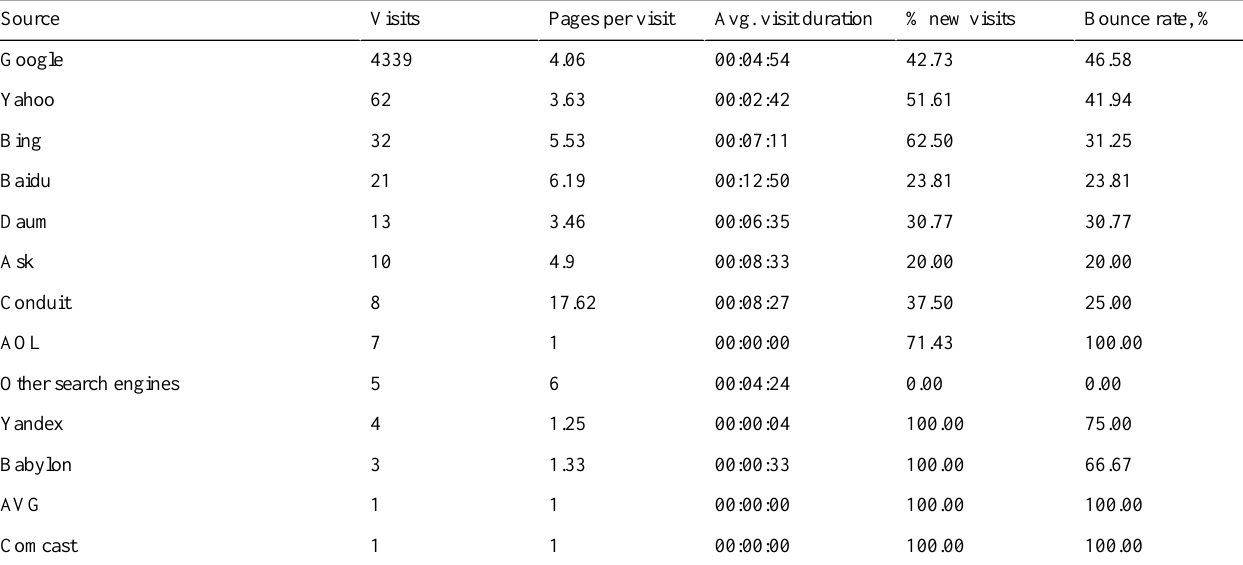
Bounce rate, %% new visitsAvg. visit durationPages per visitVisitsSource